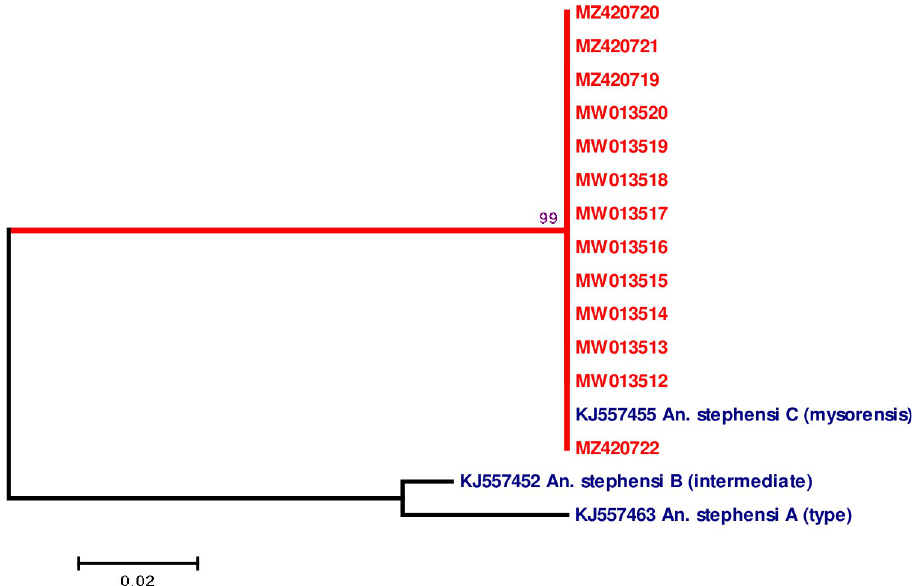
Fig 6. Phylogenetic three constructed based on Anste Obp1 intron I region of An . stephensi sequences from Lab strain China and representative sequences from GenBank.